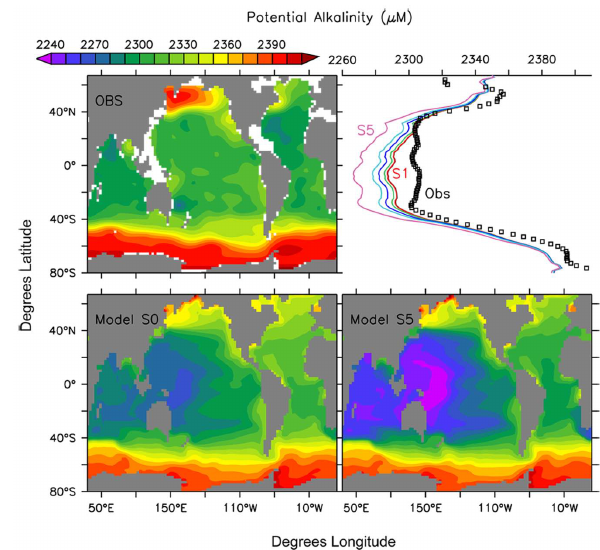
surface distributions of potential alkalinity. The top right panel shows zonally averaged values for the Key et al. (2004) GLODAP observations (squares) and the different models (coloured lines). Note that the black line representing model S0 is overlain by the red line representing model S1, because both are almost undistin-